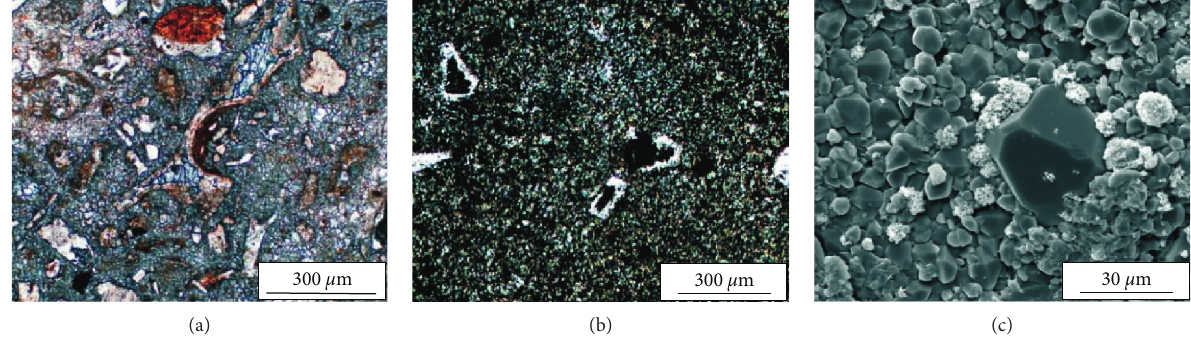
Figure 7: Analcime transformed from volcanic material [23]. (a) In vitreous clastic tuff, the vitreous clastic surface and matrix all transform into analcime. (b) Clastic tuff. (c) Crystalline tuff, in which the matrix is transformed to euhedral granular analcime. Table 3: Reported occurrences of analcime in the Green River Formation (modified according to Remy and Ferrell, 1989) [14, 54, 63–69]. Location Stratigraphic Lithology Proposed